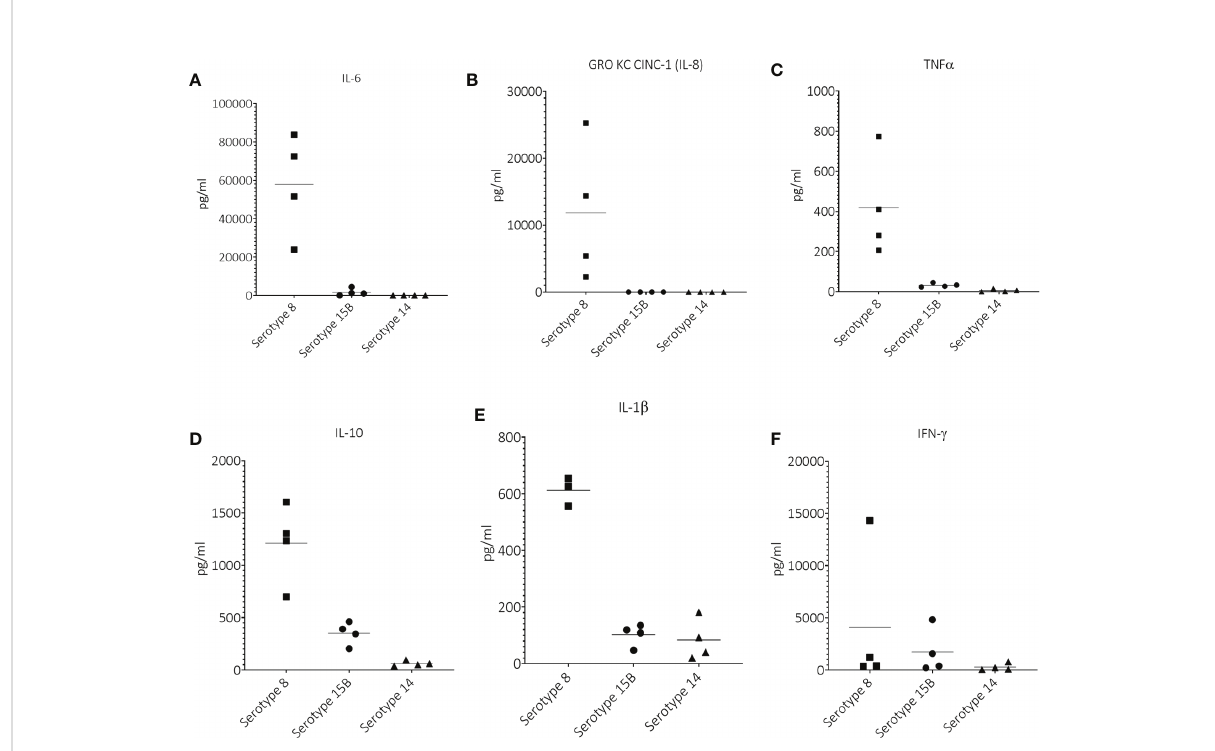
FIGURE 3 Cerebrospinal concentrations of (A) IL-6, (B) GRO KC CINC-1 (IL-8), (C) TNF a , (D) IL-10, (E) IL-1 b and (F) IFN- g at 19 hours post infection (hpi) in infant rats infected intracisternally with clinical pneumococcal strains of serotypes 8, 15B or 14. One point = one